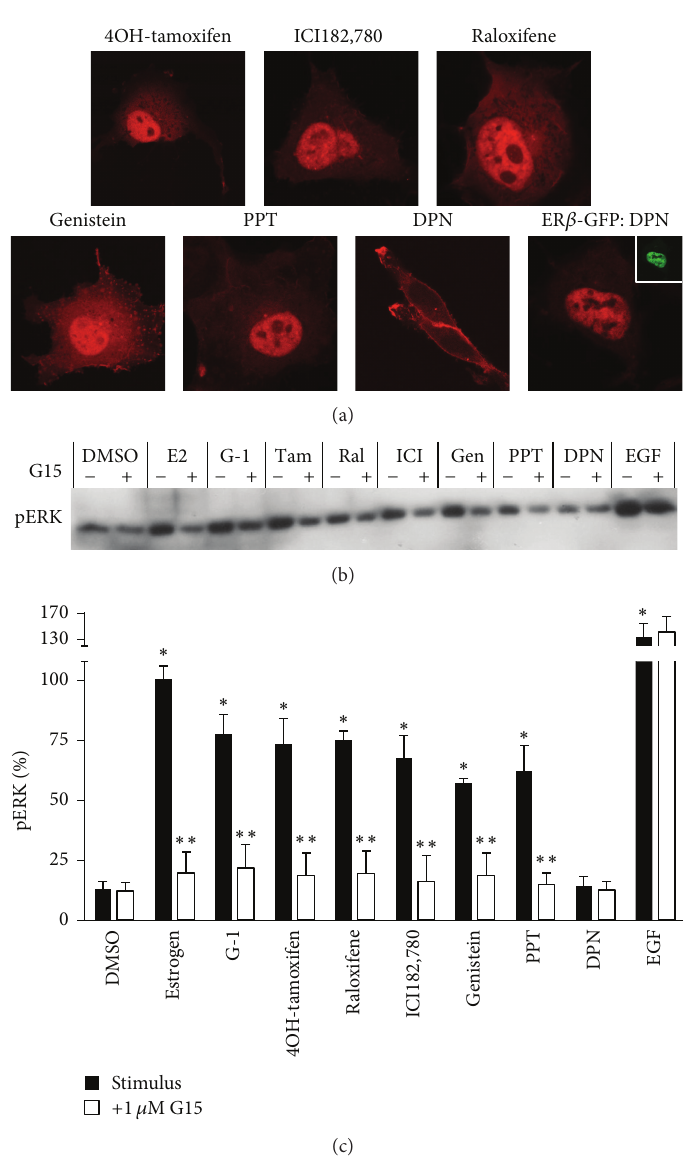
Figure 5: GPER-mediated activation of PI3K and ERK in Hec50 cells by SERMs, a SERD, and an ER 𝛼 -selective agonist. (a) PH-RFP- transfected Hec50 cells were stimulated for 15 minutes with the following ligands: 4-hydroxytamoxifen (100nM, 4OH-tamoxifen), ICI182,780 (100nM), Raloxifene (100nM), genistein (100nM), PPT (100nM), or DPN (10 𝜇 M). Hec50 cells were also cotransfected with ER 𝛽 -GFP (shown in inset) and PH-RFP and stimulated with 100nM DPN to verify the activity of DPN as an ER 𝛽 agonist in Hec50 cells (ER 𝛽 - GFP:DPN). (b) Hec50 cells were stimulated for 15min with vehicle (0.05% DMSO), estrogen (10nM, E2), G-1 (10nM), 4-hydroxytamoxifen (100nM, Tam), Raloxifene (100nM, Ral), ICI182,780 (100nM, ICI), genistein (100nM, Gen), PPT (100nM), DPN (10 𝜇 M), or EGF (1nM) either in the presence or absence of 1 𝜇 M G15 (10min pretreatment, with 0.05% DMSO in samples without G15). (c) Band intensities of pERK were normalized to total ERK and plotted with estrogen as 100%. Data represent mean ± s.e.m. from three experiments. ∗ 𝑃 < 0.05 versus DMSO; ∗∗ 𝑃 < 0.05 versus paired stimulus without